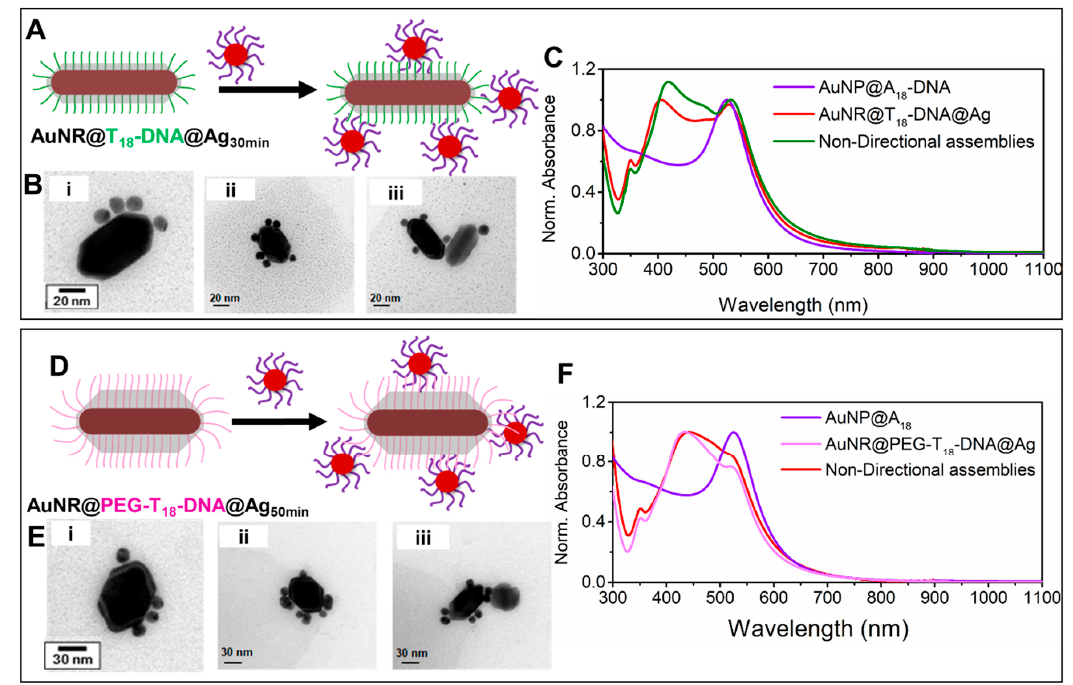
Figure 4 . Nondirectional nanoassemblies obtained upon incubation of AuNRs@T 18 -DNA@Ag (overgrown for 30 min, left panel) or of AuNRs@PEG-T 18 -DNA@Ag (overgrown for 50 min, right panel) with AuNPs@A 18 -DNA. ( A , D ) Schematic illustration of the formation of nondirectional nanoassemblies for both cases. ( B , E ) Representative TEM micrographs of the corresponding nondirectional nanoassemblies. ( C , F ) UV–Vis–NIR spectra of the respective building blocks and their resulting nondirectional nanoassemblies.